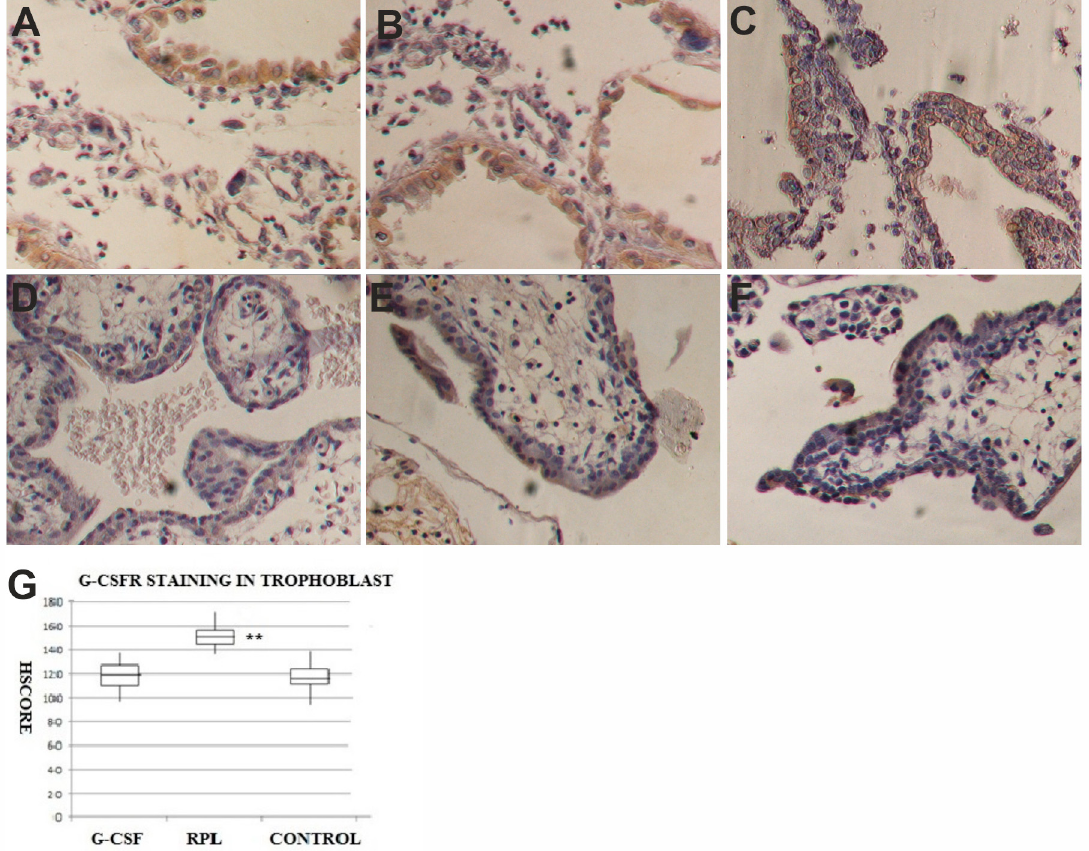
Figure 2. G-CSF expression in decidua and trophoblast of first trimester pregnancy. In decidua of G-CSF treated group ( A ), in the no treated RPL group ( B ) and Control pregnancies ( C ) there was the same staining levels in the epithelial cells but no in the stroma for G-CSF (brown color) (400 × ). In trophoblast of G-CSF treated samples ( D ), the syncytiotrophoblast was positive to G-CSF (brown color) (400 × ). In trophoblast of RPL no-treated samples ( E ), the syncytiotrophoblast was weakly positive to G-CSF (400 × ). In trophoblast of Control samples ( F ), the syncytiotrophoblast was positive to G-CSF (brown color) similar to G-CSF treated samples (400 × ). The graph ( G ) showed immunohistochemical staining semi quantitative HSCORE for G-CSF (Charts display median and quartiles with whiskers showing the range): There was statistically significant di ff erences between G-CSF vs. RPL (* p < 0.001) and RPL vs. Control (** p < 0.001).